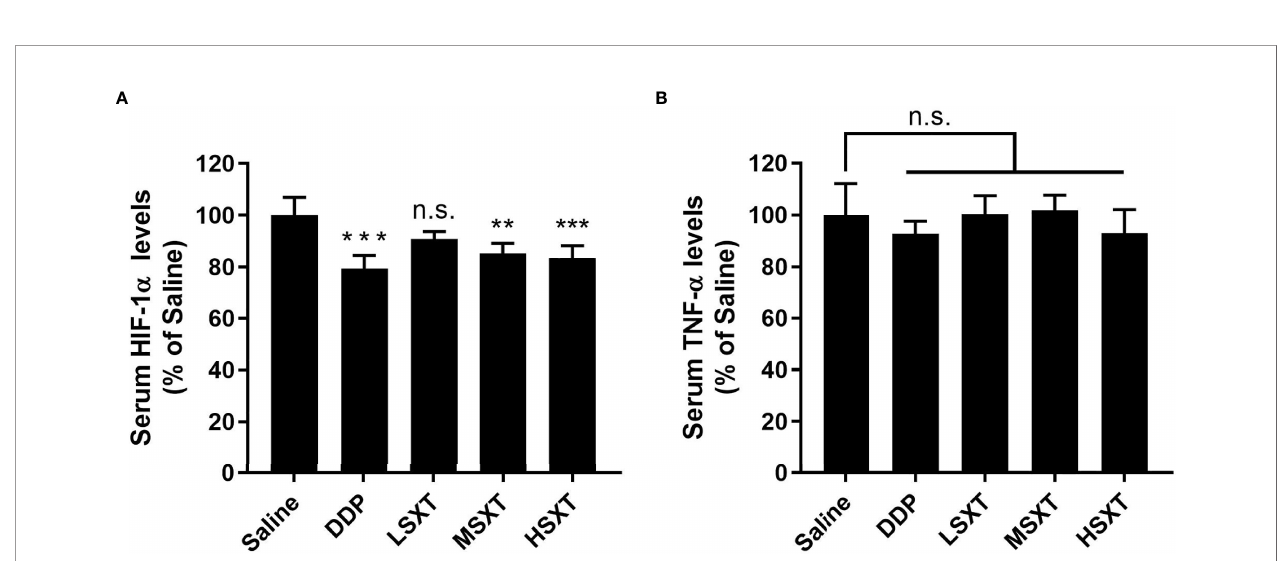
FIGURE 5 | Relative expression levels of serum HIF-1 a (A) and TNF- a (B) determined by ELISA (mean ± S.D., n = 5), **P < 0.01, ***P < 0.001, n.s., no signi fi cance (one-way ANOVA test to saline). SXT treatment at medium (MSXT; 28.65 g/kg/d) and high (HSXT; 38.20 g/kg/d) doses decreased the levels of HIF-1 a , but not TNF- a . DDP was used as a positive